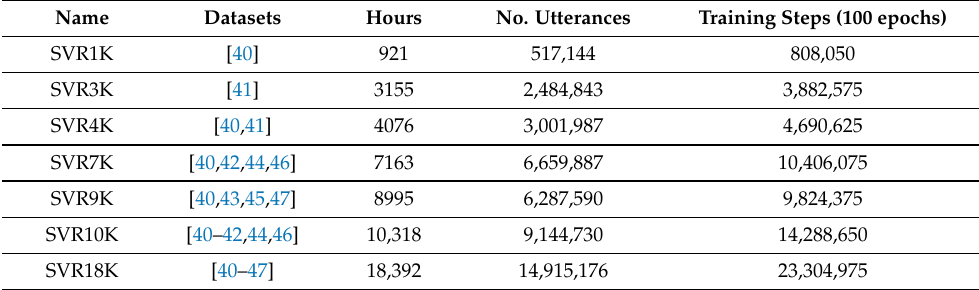
Table 4. Total pretraining steps of various dataset combinations until 100